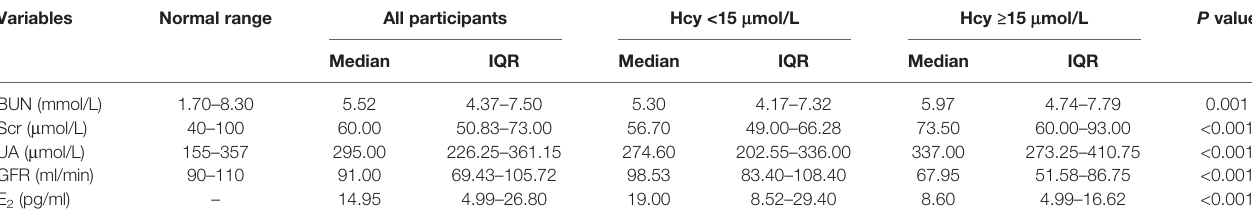
TABLE 2 | Differences of renal function indicators and estradiol in the study population.